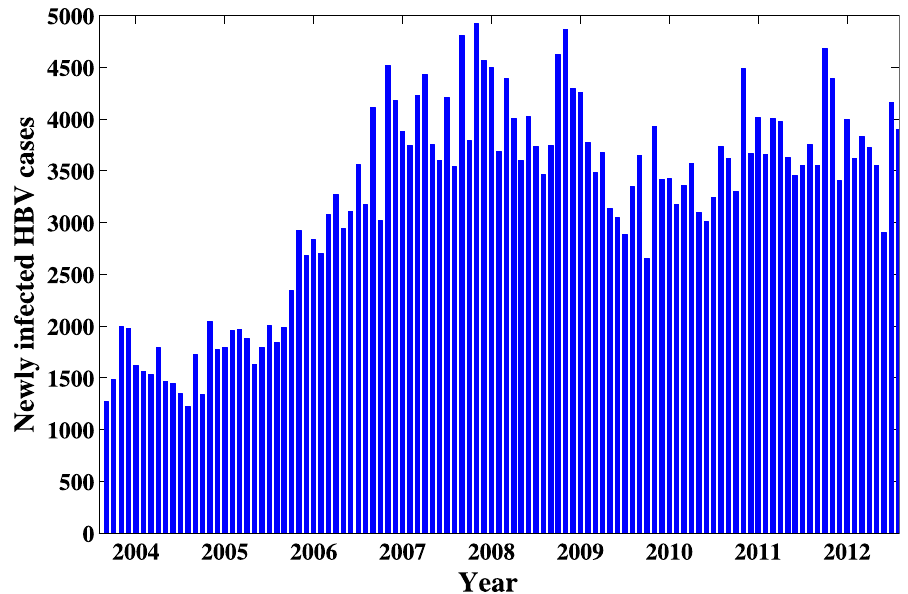
Fig 2. Monthly new reported HBV case in Xinjinag from 2004 to 2012. The Data was obtained from the website of public health science data center.